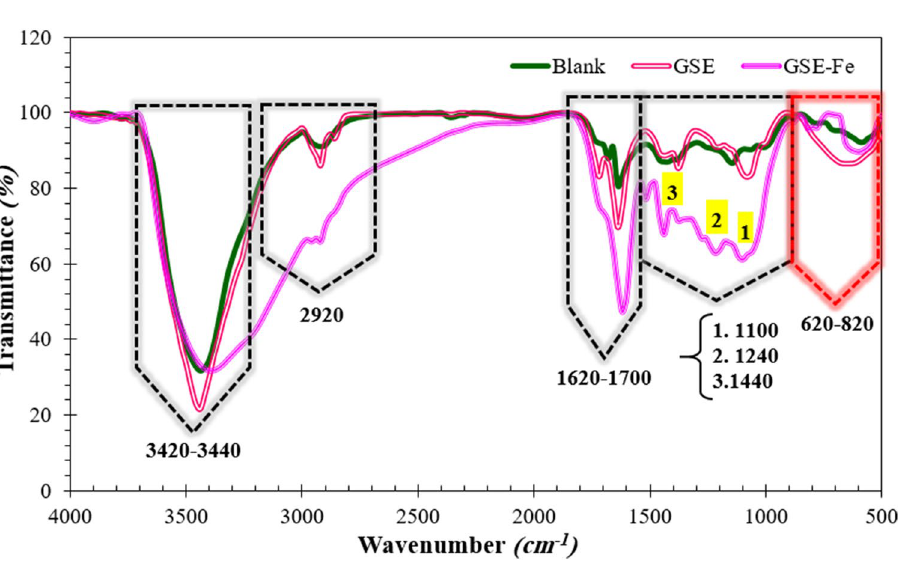
Figure 12. FTIR spectrum of MS immersed for 3 h in the test solution with and without GSE; the GSE-Fe complex is provided as a reference